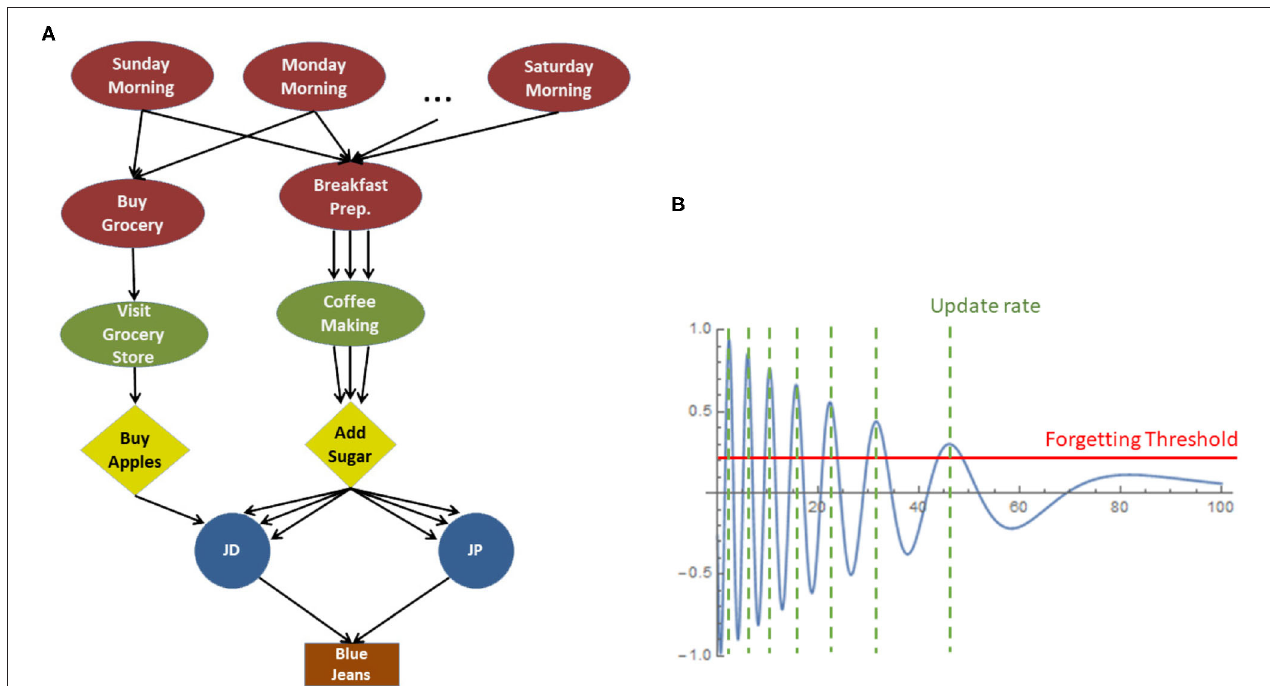
FIGURE 3 | (A) Connected Episodic Multi-graph. (B) Exemplar importance function.